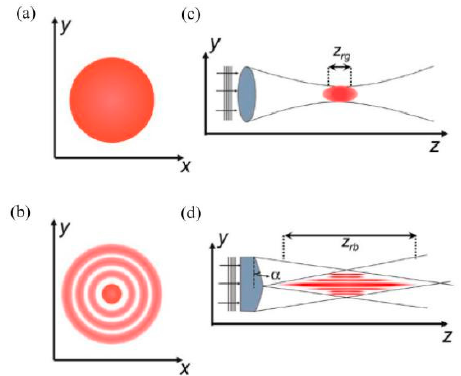
Figure 17. Schematic of ( a ) Gaussian; ( b ) zero-order Bessel beam profiles in the x-y plane; ( c ) and ( d ) represent the z-axis propagation and focusing properties of Gaussian and Bessel beams [180].